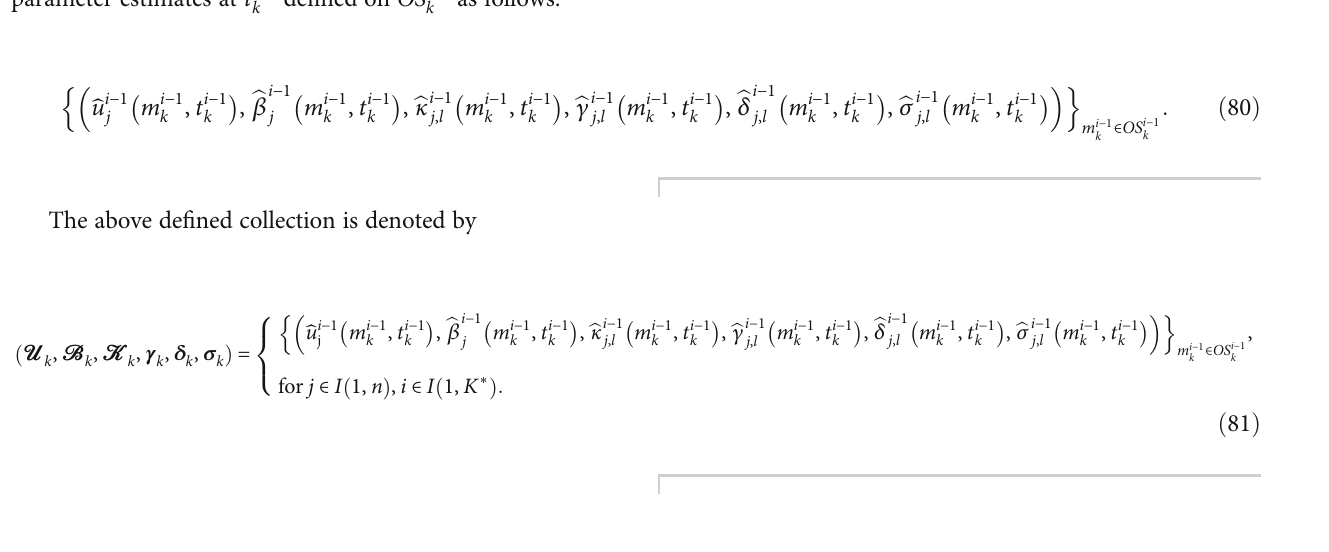
ð ̂ m ð ̂ m , k Þ , β , k Þ , and β k k 1 2